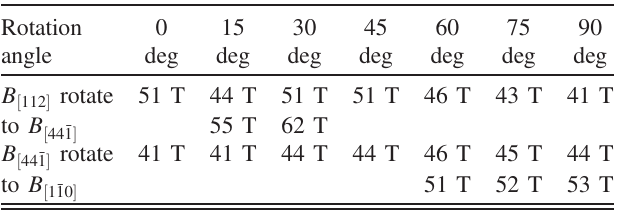
TABLE I. FFT analysis of SdH oscillations in various magnetic field directions.